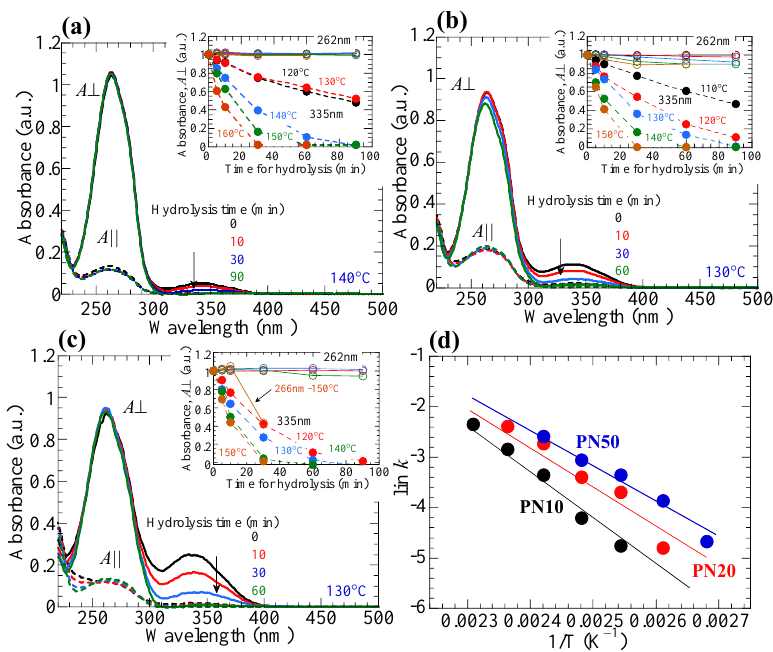
Figure 8. Changes in the polarized absorption spectra when oriented ( a ) PN10 , ( b ) PN20 , and ( c ) PN50 films are annealed at 140 °C ( PN10 ) or 130 °C ( PN20 , PN50 ) under RH=100 % atmosphere. Insets plot the changes in the normalized A ⏊ values at 262 and 335 nm annealed at various temperatures under RH = 100% atmosphere as functions of the hydrolysis time. ( d ) Arrhenius plots of the hydrolysis of PNx films.